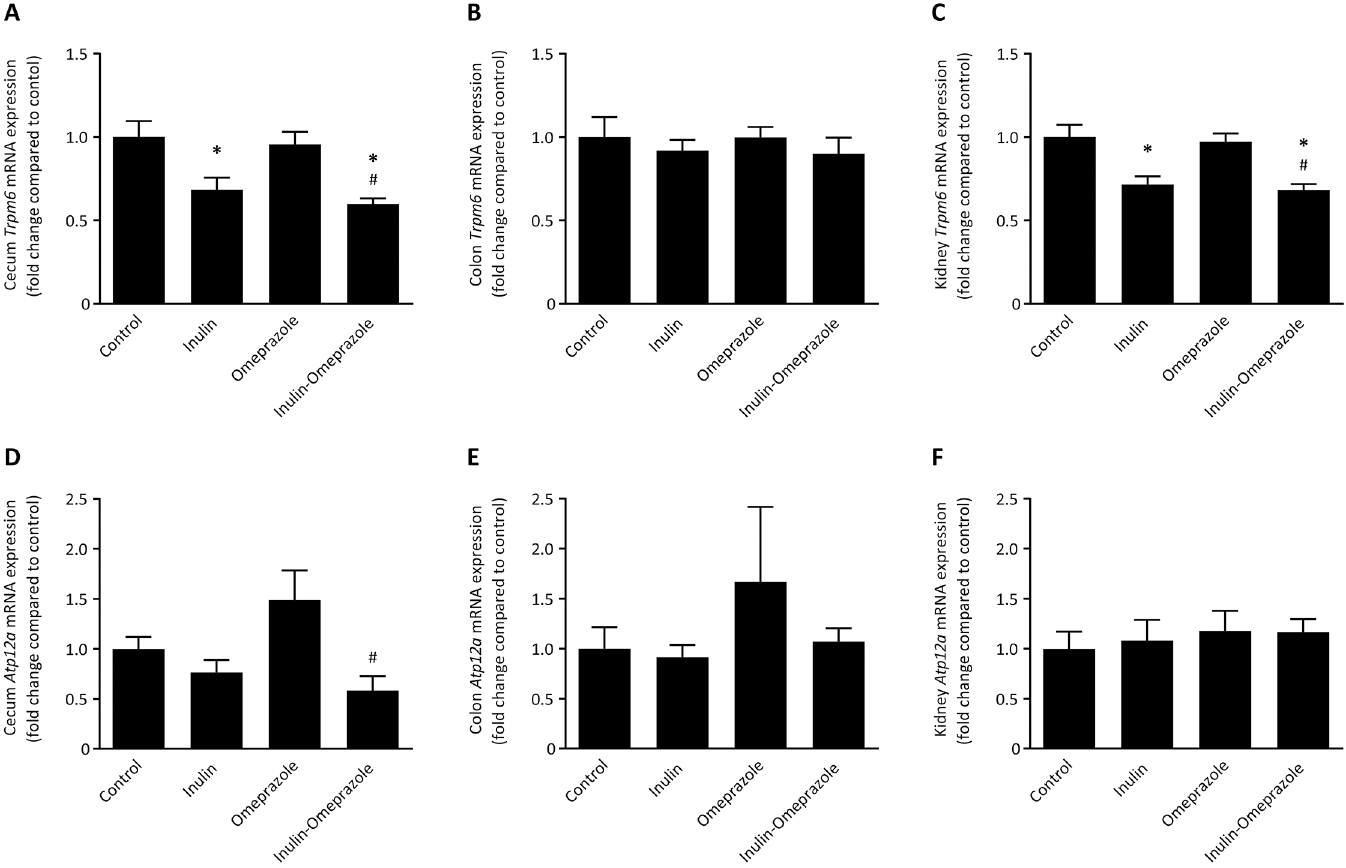
Fig 2. Effects of omeprazole treatment and diets enriched with 10% (w/w) inulin on mRNA levels of PPIH candidate genes. Expressional levels of Trpm6 and Atp12a , encoding the nongastric H + ,K + -ATPase in cecum (A + D), colon (B + E) and kidney (C + F) of C57BL/6J mice compared to control (corrected for Gapdh expression). Significant differences compared to control are indicated by * with P < 0.05, significant differences between the omeprazole-treated groups are annotated by # with P < 0.05. All values represent means ± SEM, with n = 10 mice per group.